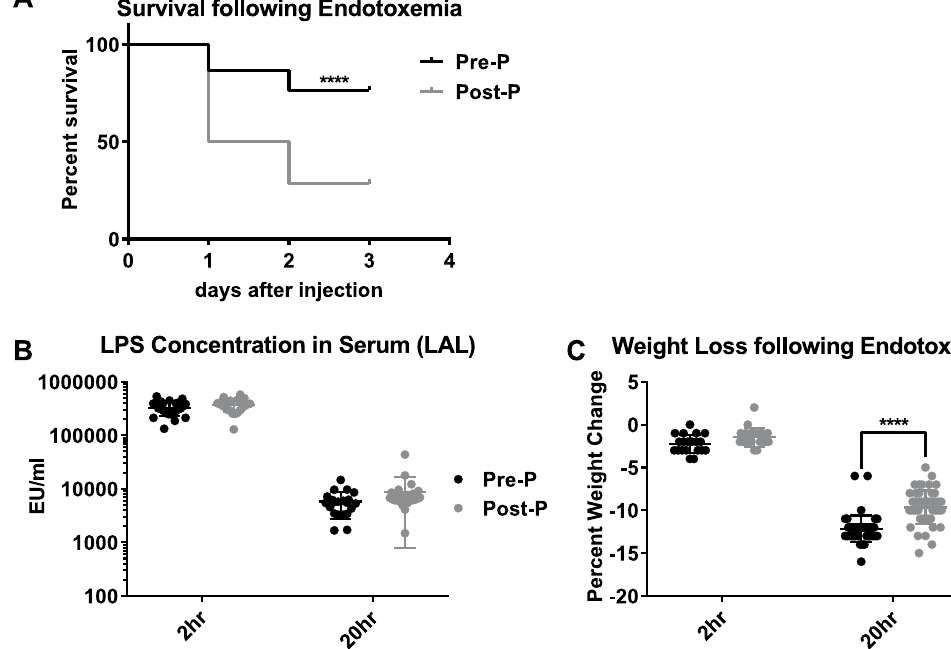
Figure 1. Pre-pubertal mice show increased resistance to mortality from endotoxemia. (A) Pre-pubertal (Pre-P) and post-pubertal (Post-P) C57Bl/6 mice received 23 μ g/mg LPS via intra-peritoneal injection. Mice were monitored twice daily and moribund individuals humanely euthanised (N ≥ 56/group). (B) Endotoxin concentrations in serum samples collected at 2- and 20-hour time-points were quantified using LAL (N ≥ 21/ group). (C) Mouse weight was recorded prior to LPS injection and then at 2- and 20-hour time points. Data is shown as the per cent change in weight in comparison to time 0 (N ≥ 20/group). Per cent survival was compared using a log rank Mantel Cox test, while endotoxin concentration and weight loss were compared using Two-way ANOVA followed by Tukey’s multiple comparisons test. Significant differences between pre- and post-pubertal mice are labelled with **** (p <